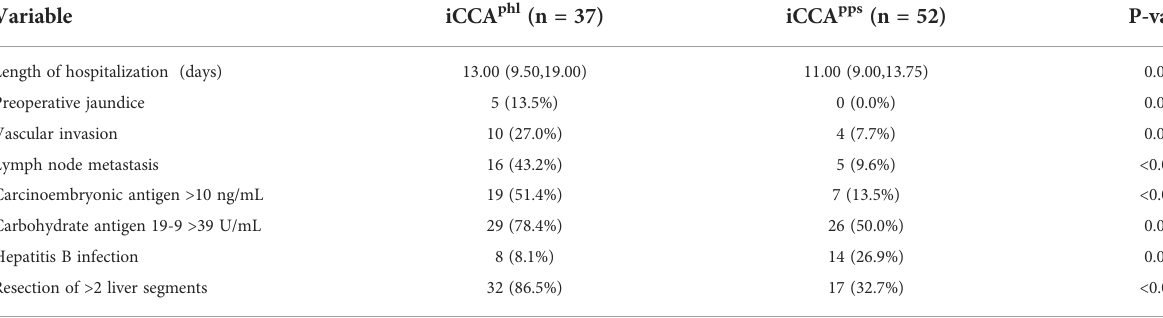
TABLE 1 Pairwise comparison of the two types of intrahepatic cholangiocarcinoma.